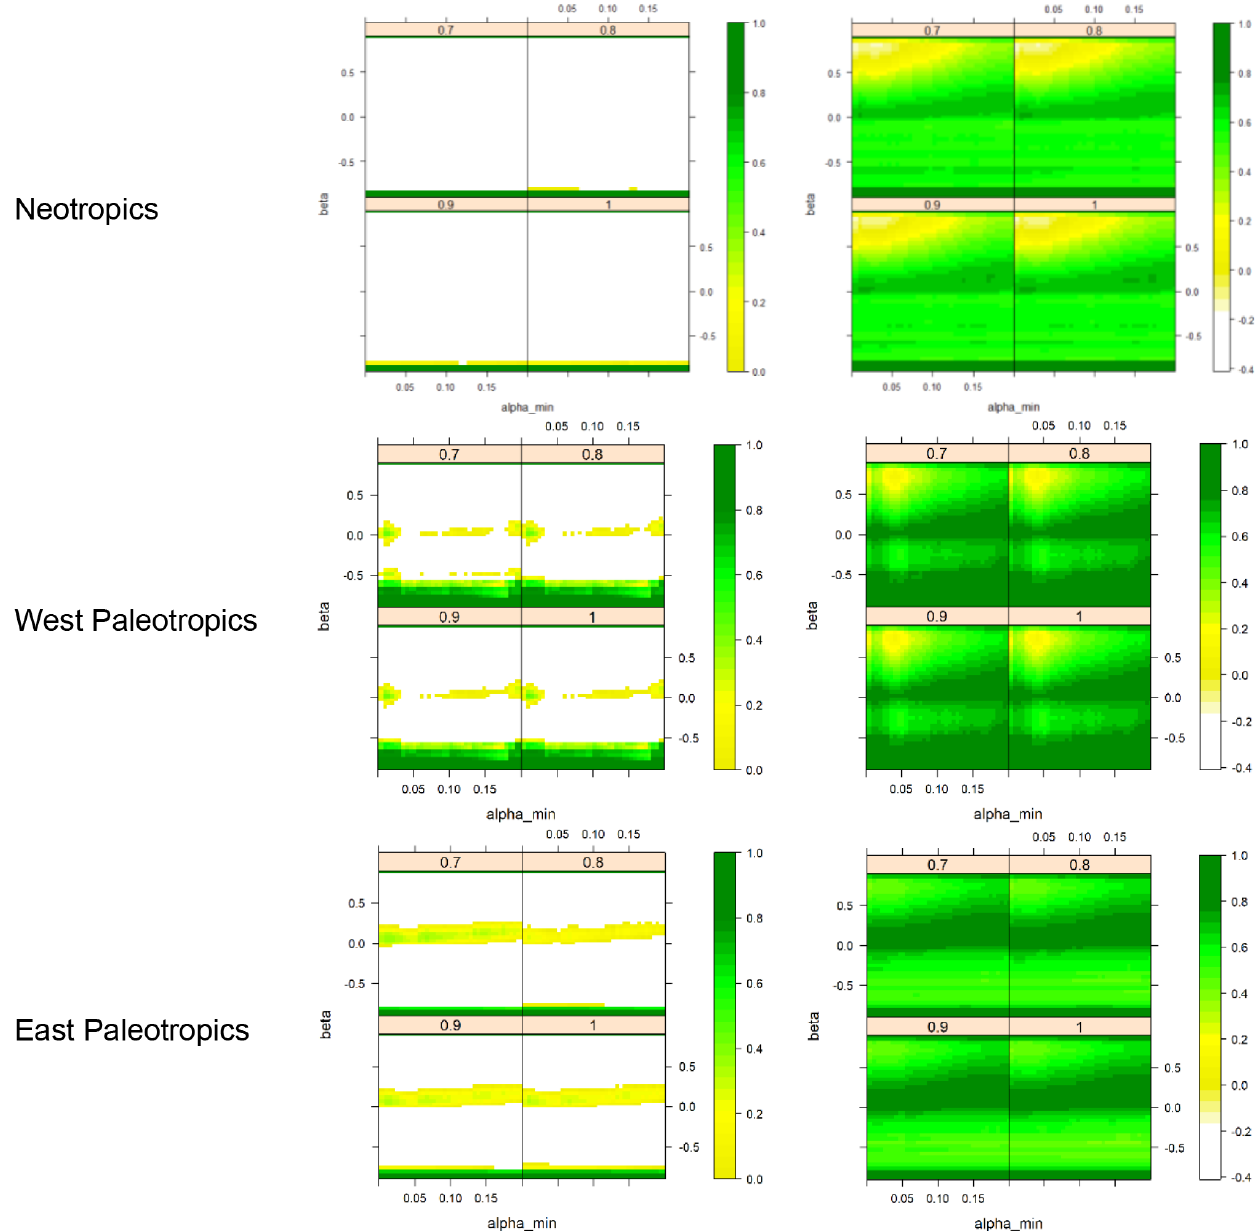
Figure 6. State space plots for evaluation statistics based on inundated grid-cell fraction, calculated from varying parameters α min and beta , with panels showing values of α max . Each point is the mean of all NSE or KGE values, averaged both over time (years 1992–2014) and over the wetland region concerned (white indicates no value could be